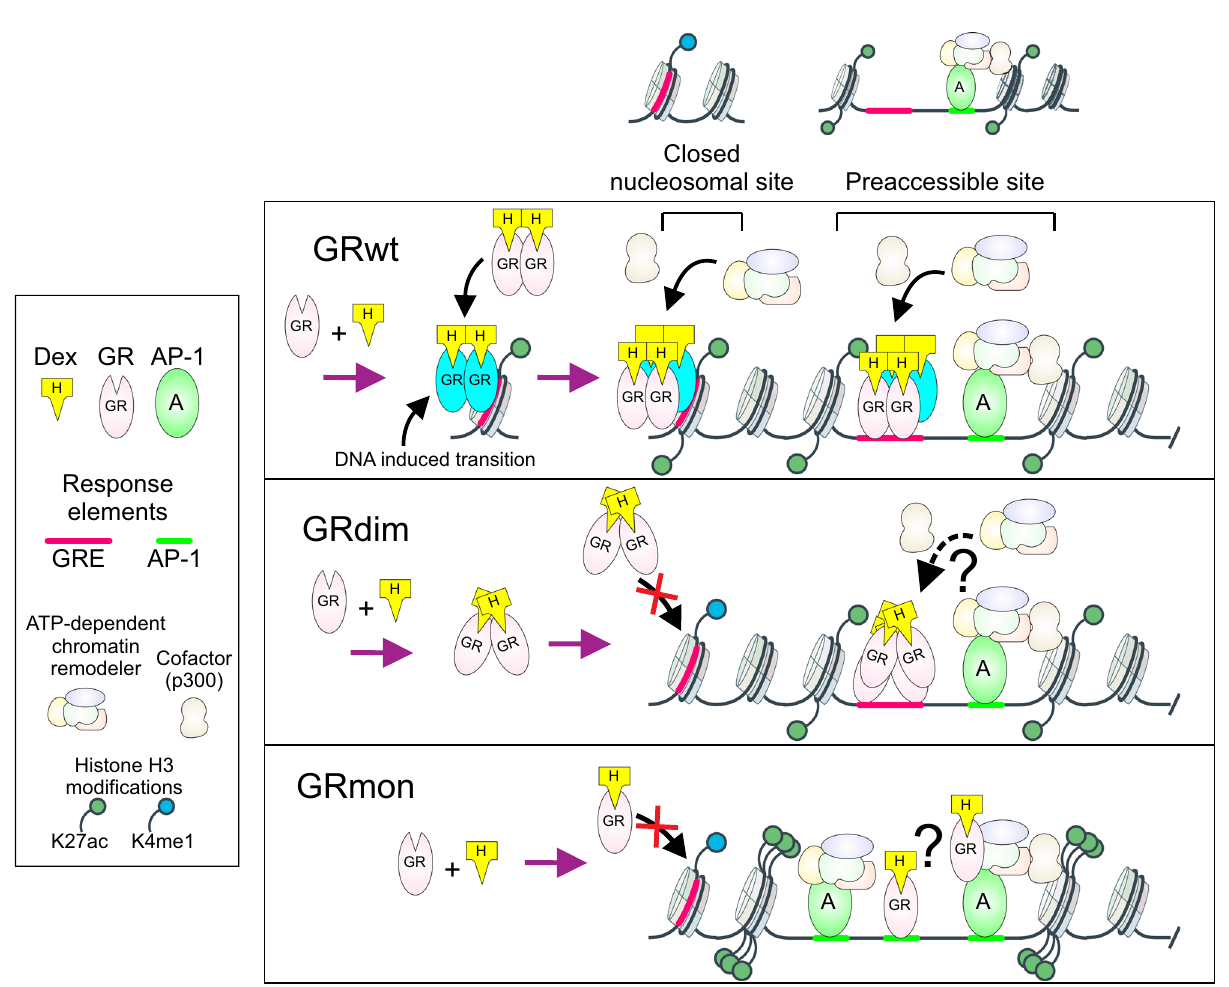
Fig. 7 Model of GRwt, GRdim, and GRmon action on chromatin. Binding of liganded GR to chromatin induces a transition from a dimeric to tetrameric state. GRwt can bind to closed nucleosomal sites and to pre-accessible sites. GRwt can recruit chromatin remodelers and other cofactors to both closed and pre-accessible sites to increase chromatin accessibility and in fl uence gene expression. AP-1 (or other initiating factors) maintain chromatin pre- accessible sites prior to receptor binding. GRdim can bind only to pre-accessible sites, where it can recruit chromatin remodelers and other cofactors to a limited extent. GRmon can only bind to strongly pre-accessible sites with high amount of active histone modi fi cations. GRmon can potentially tether to other transcription factors such as propose that the dissociated model of GR function, established primarily by early in vitro studies using the GRdim mutant is no longer consistent with the current literature. Our data and re- with 5 μ g/ml tetracycline (Sigma – Aldrich #T7660), 10% fetal bovine serum analyses of previous genome-wide data indicates GR must form at (Gemini), sodium pyruvate, nonessential amino acids, and 2mM glutamine least a dimer to bind chromatin as measured by ChIP, and that maintained in a humidi fi er at 37C and 5% CO 2 . Cells were plated for experiments binding does not necessarily lead to ef fi cient gene response. Our in DMEM growth medium supplemented with 10% charcoal/dextran-treated genome-wide data, taken together with our microscopy studies, serum for 24h prior to hormone treatment. indicate no separation between receptor oligomerization status From our previously published GR knock-out (GRKO) cell line 22 , we used CRISPR/Cas9 methods 55 to reintroduced the GFP-tagged mouse WT, the mouse and whether GR functions as a transcriptional activator or GR A465T (GRdim) mutation or the mouse GR A465T/I634A (GRmon) double repressor. This has important implications for the therapeutic uses mutation via the GT(Rosa)26Sor locus. The mutant GR sequences were generated of steroid hormones and the goal of fi nding selective anti- using a QuikChange II XL Site-Directed Mutagenesis Kit according to the in fl ammatory drugs that do not create unwanted side-effects. manufacturer ’ s instructions (Stratagene). The three GFP-GR containing cell lines